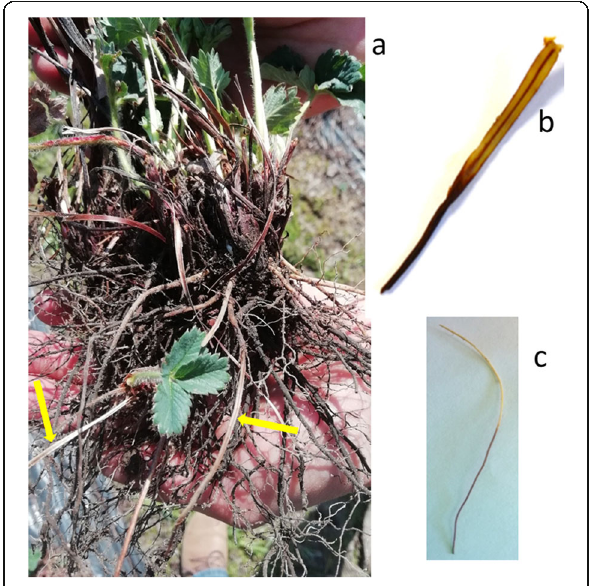
Fig. 1 Typical symptoms of red stele disease of strawberry. a A stunted plant held by hands. The plant is suffering from red stele disease and the yellow arrows are pointing to the dissected rat-tails displaying red cores. b A detached dissected rat-tail root displaying red core. c A fully pealed root core prior to plating on Phytophthora selective agar. The lower part of the core has turned red due to red stele